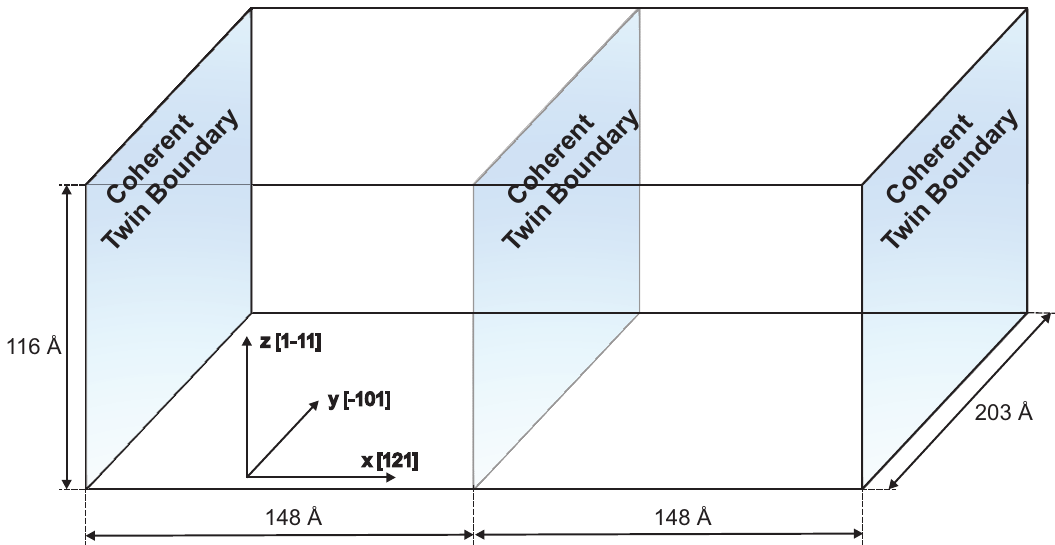
Figure 1. The simulation setup used to predict the behavior of crystals containing two coherent twin boundaries. Periodic boundary conditions were used for all three normal directions. The blue surface marks the (121)